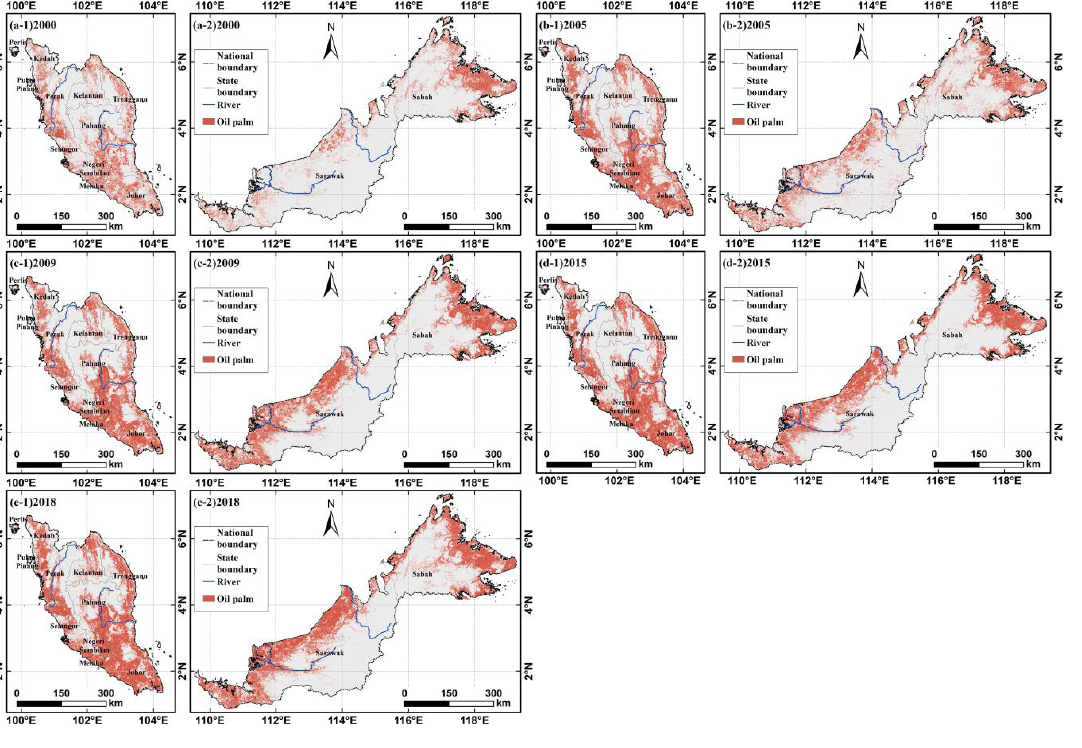
Figure 5. Oil palm planting distribution during 2000–2018. The letters a, b, c, d, and e represent 2000, 2005, 2009, 2015, and 2018, respectively. The numbers 1 and 2 represent West Malaysia and East Malaysia, respectively.